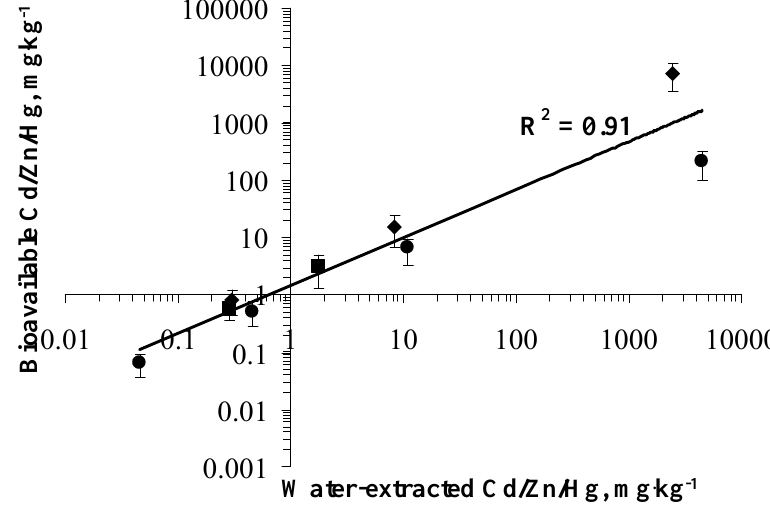
samples 1-13. Water-extracted (determined from water extracts of soil samples 1-13 by AAS) fractions of Cd (  ), Hg (  ) and Zn (  ) plotted against respective bioavailable (measured by heavy metal sensor bacteria) fractions. R 2 of correlation between water- extracted and bioavailable fractions of Cd, Zn and Hg is presented.